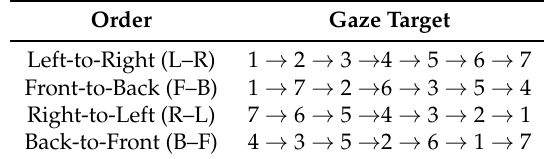
Table 3. Experiment 1: Direction variation.